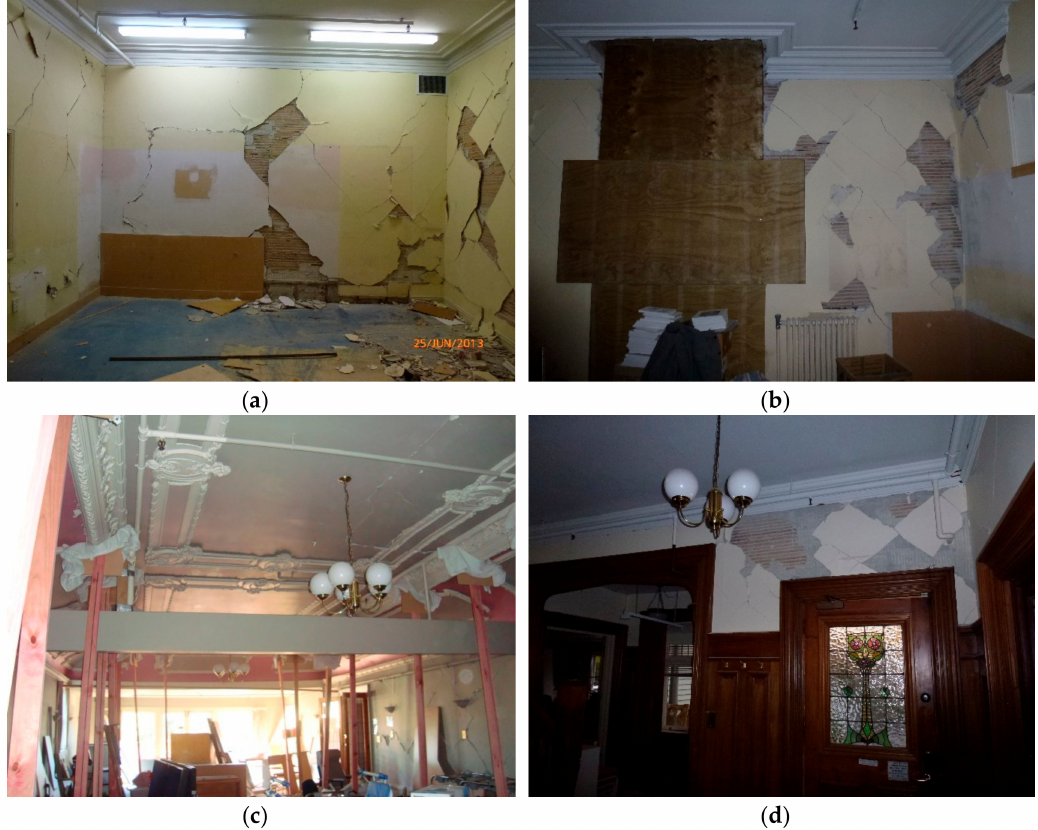
Figure 2. Typical interior damages throughout McDougall House: ( a ) Damages on lath and plaster walls; ( b ) Section of a removed chimney; ( c ) Cracked ornamental plasterwork ceiling in the Ballroom; ( d ) Damages on a composite lath and plaster wall with heritage timber